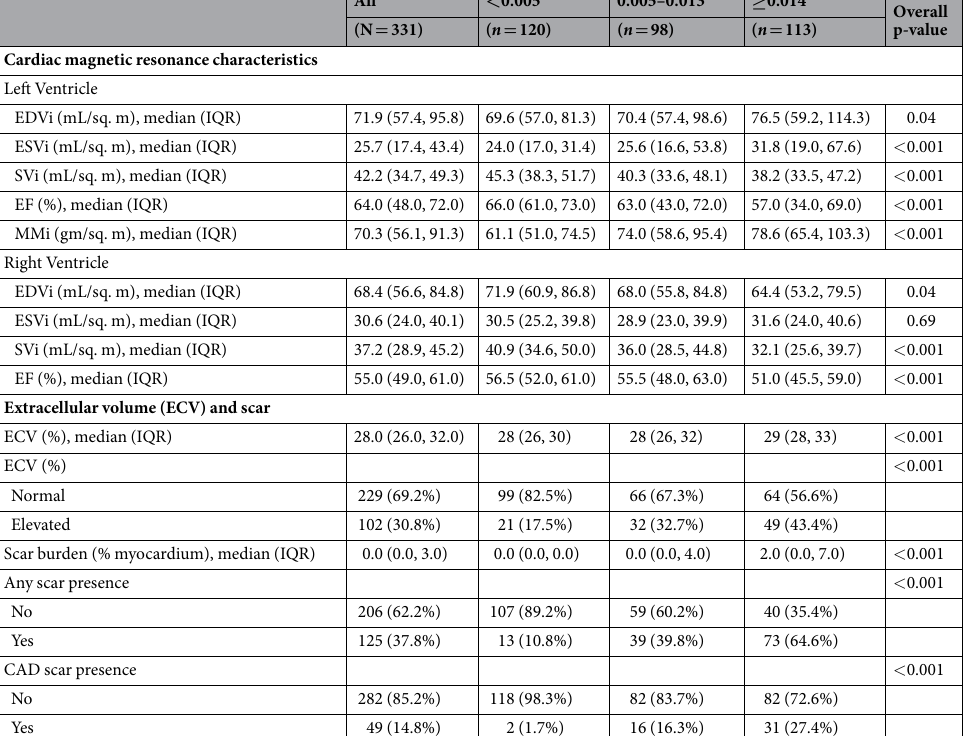
Table 3. Cardiac magnetic resonance characteristics and categorization by high-sensitivity cardiac troponin T levels. IQR, interquartile range; EDVi, end-diastolic volume index; ESVi, end-systolic volume index; MMi, myocardial mass index; SVi, stroke volume index; EF, ejection fraction; ECV, extracellular volume; CAD, coronary artery